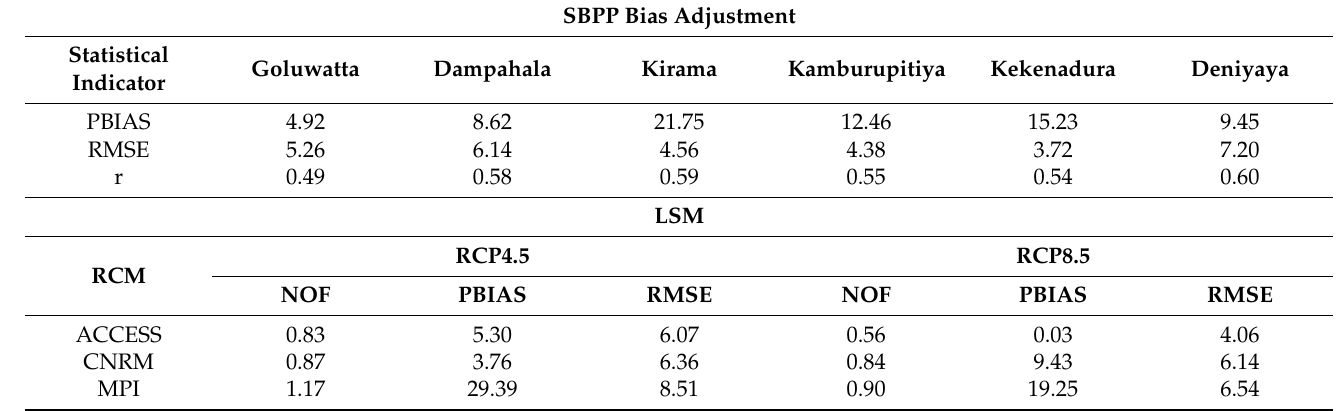
Table 3. Results of the statistical performance of SBPP bias adjustment and LSM. SBPP Bias